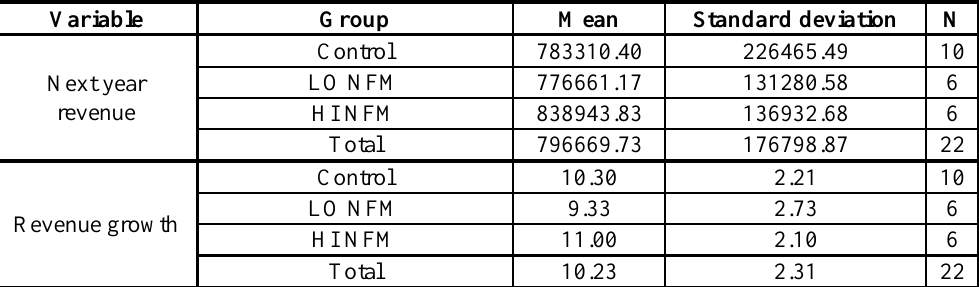
Table 1. Descriptive statistic (non-financial information alone and low knowledge)